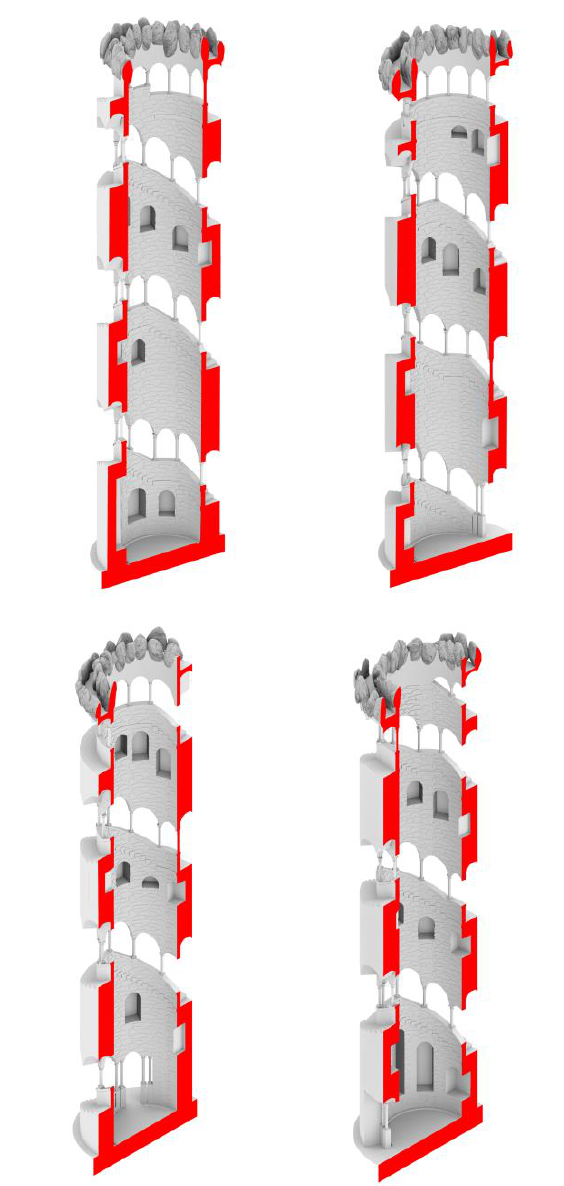
Figure 14 . The Quinta da Regaleira in Sintra, the Poço Iniciatico , model cross section.